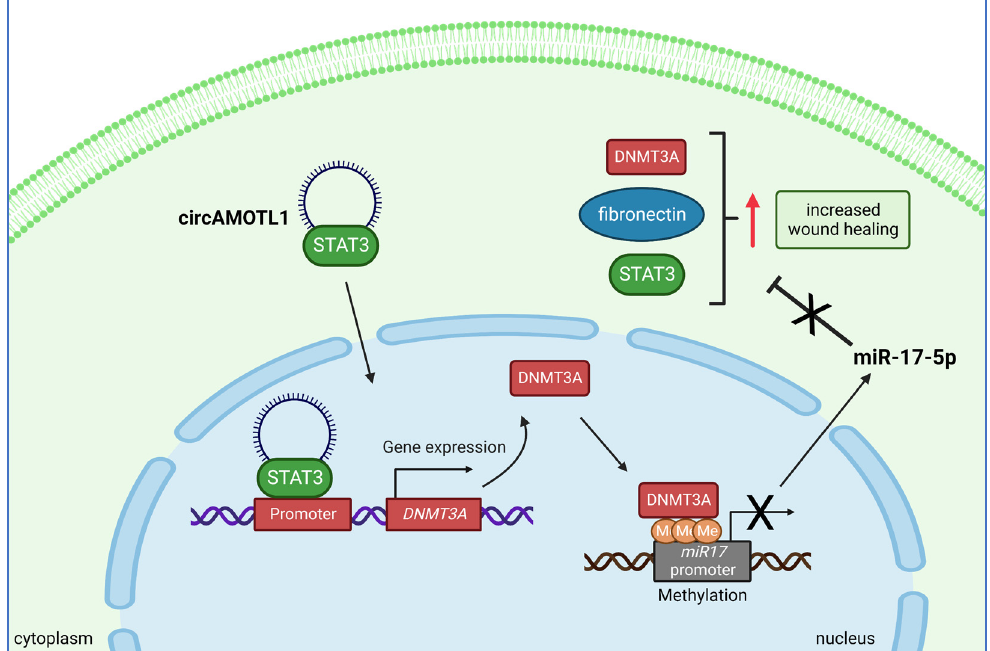
Figure 7. CircAMOTL1 plays an important role in wound healing. During this process, fibroblasts intensively proliferate and migrate into the wounded area. Migrating cells have increased levels of circAMOTL1, which interacts with STAT3 in the cytoplasm and facilitates its translocation into the nucleus. Nuclear STAT3 binds to the regulatory elements of the DNMT3A gene, stimulating expression. As a result, DNMT3A binds to the miR-17 promoter and deactivates it by methylation. This leads to decreased levels of miR-17-5p and increased levels of DNMT3A, fibronectin, and STAT3, which promotes wound